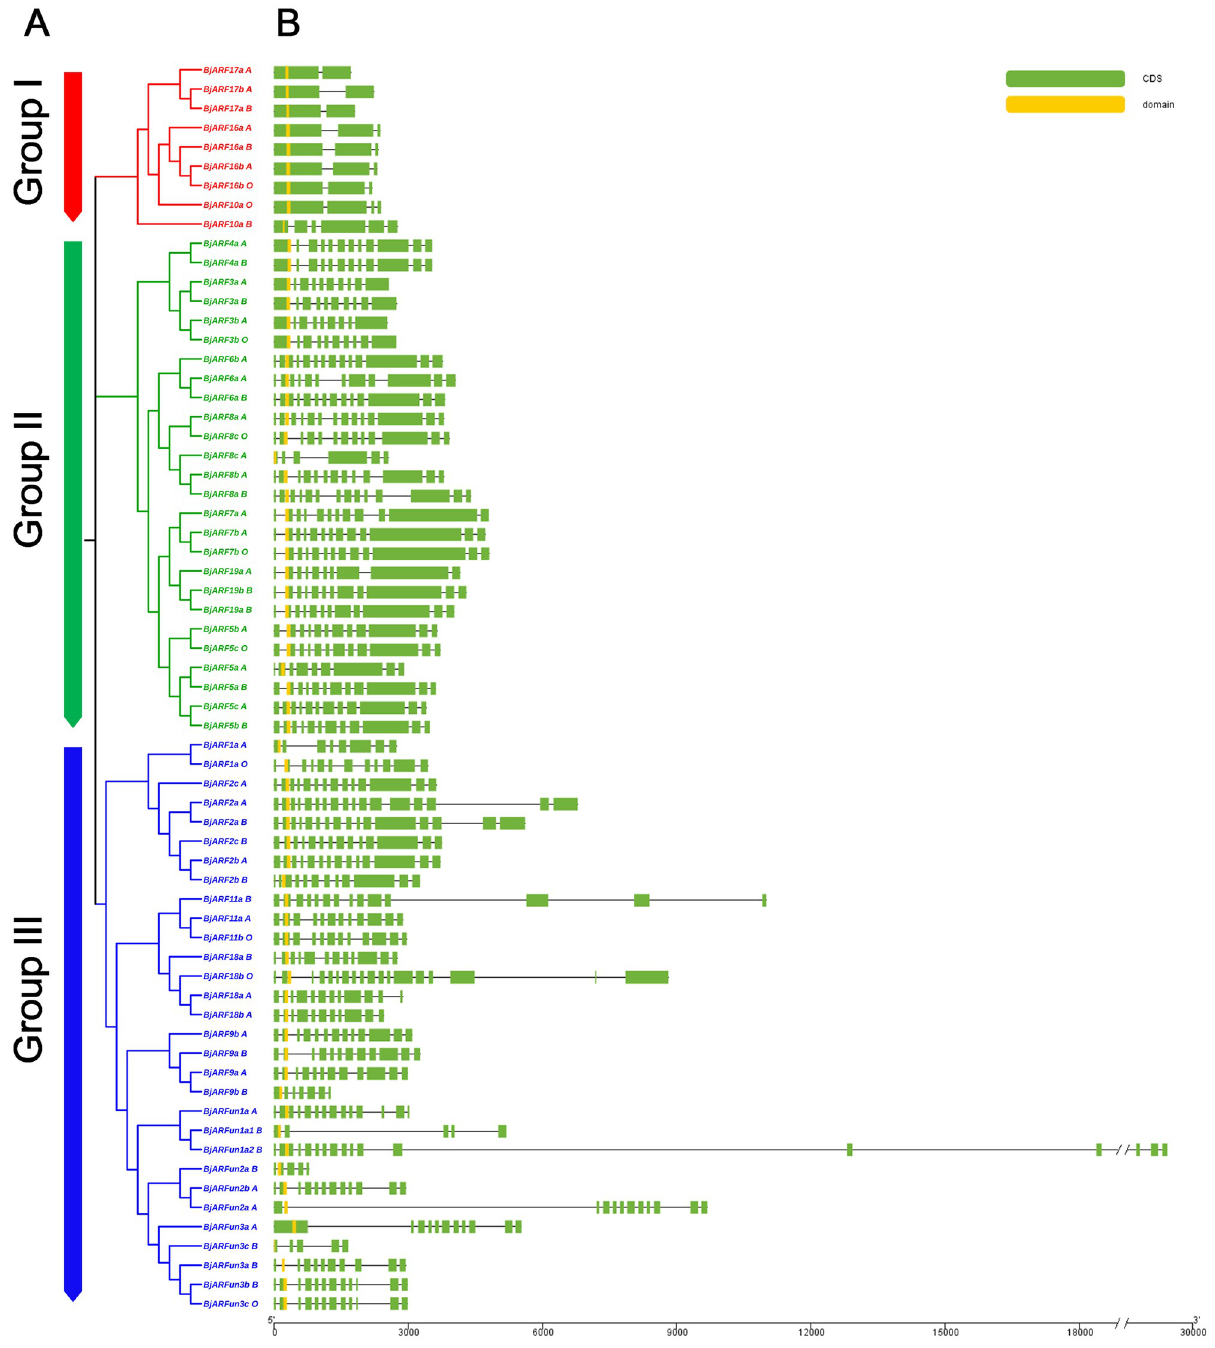
Fig 3. Phylogenetic tree of the ARF genes and genomic organization of ARF genes in B . juncea . A. NJ tree of BjARFs ; the Auxin_resp domain was identified and the phylogenetic tree was constructed using MEGA 7, via the Neighbor-Joining method with 1000 bootstraps. Different groups of the ARF family are shown in different colors. B. Exon and intron structures of BjARFs , CDSs are shown in green, black lines connecting two CDSs represent introns.